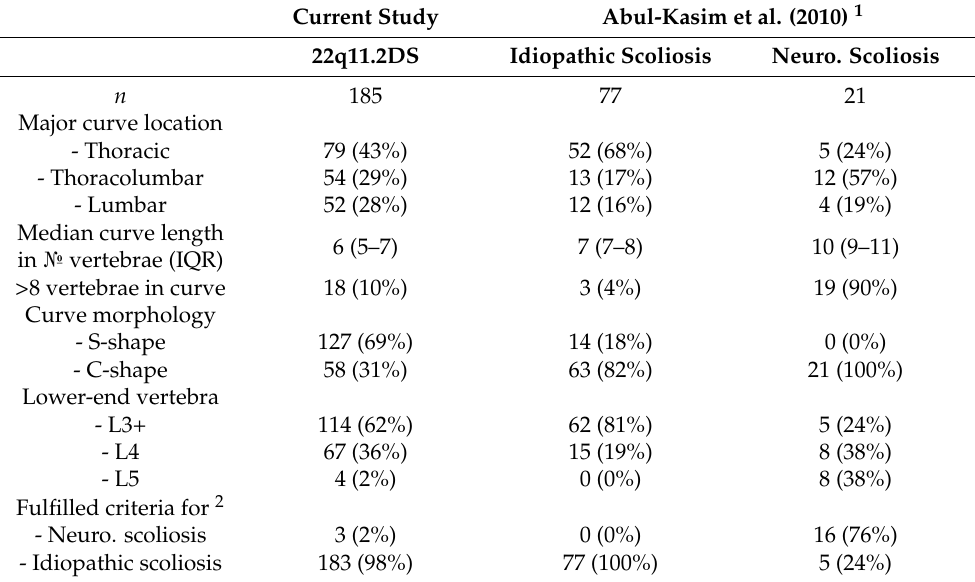
Table 1. Curve characteristics of the 185 ambulant 22q11.2 deletion syndrome patients with scoliosis next to references values of the idiopathic and neuromuscular scoliosis. From Abul-Kasim et al. (2010).